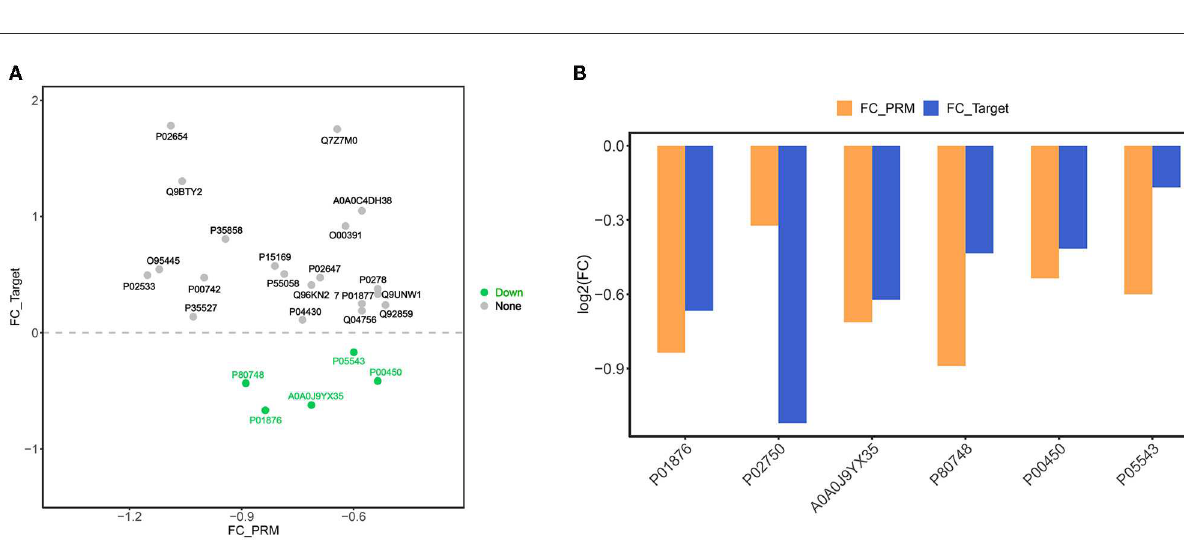
FIGURE7 (A) Scatter plot of target protein expression distribution. The x-axis is the log2 (FC) value of PRM-identified proteins, and the y-axis is the log2 (FC) value of DIA target proteins. Green dots indicate proteins with down-regulated expression trends of both PRM and DIA, orange dots are proteins with up-regulated expression of both PRM and DIA, and gray dots are proteins with inconsistent expression trends of both. (B) Bar chart of target protein expression trend. The x-axis is the ID of the protein with consistent expression trend of PRM and DIA, and the y-axis is the log2 (FC) value of the corresponding protein. log2 (FC) > 0 is the protein with up-regulated expression, and log2 (FC) > 0 is the protein with down-regulated